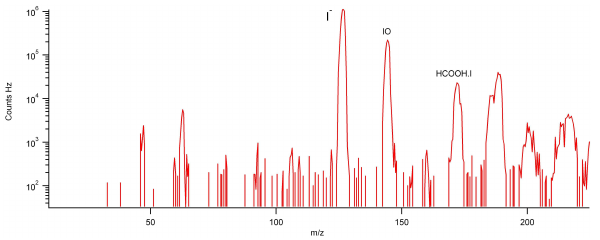
Fig. 2. Mass spectrum of CIMS during flight B518, 16 March 2010 at 16:00. Ionization peaks and formic acid adduct mass are labelled. Peaks at m/z 190, 201, 215 correspond to HNO 3 , propanoic and butanoic acid, respectively. The FWHM is 1amu at m/z =173.